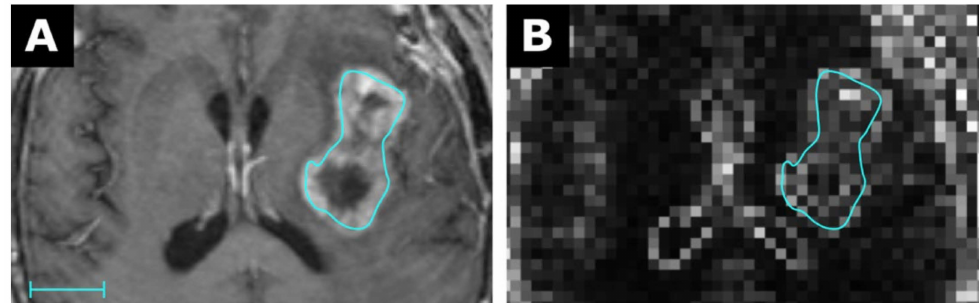
Figure 5. MRI of a glioblastoma ( A ) with a corresponding map for the feature Robust Mean Absolute Deviation (RMAD) with a resolution of 3 × 3 × 3 mm in ( B ). Scale indicates 2 cm. The value for RMAD from the conventional extraction was 42.3 and 18.0 for the map. Details are available in electronic Table S3.